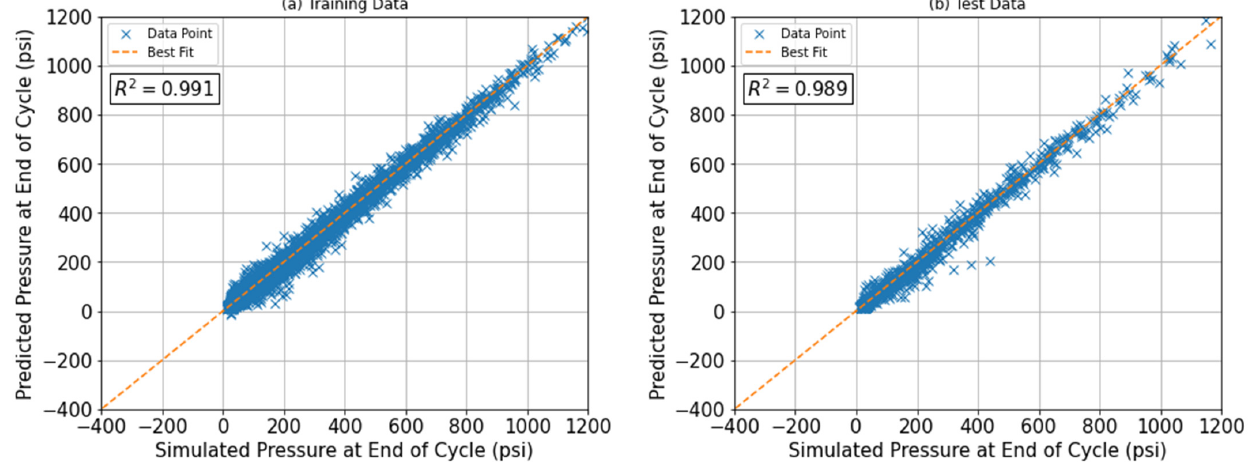
Figure 12. Predicted and simulated plot of ( a ) training data and ( b ) testing data for reservoir pressure at the end of the cycle—neural network model.